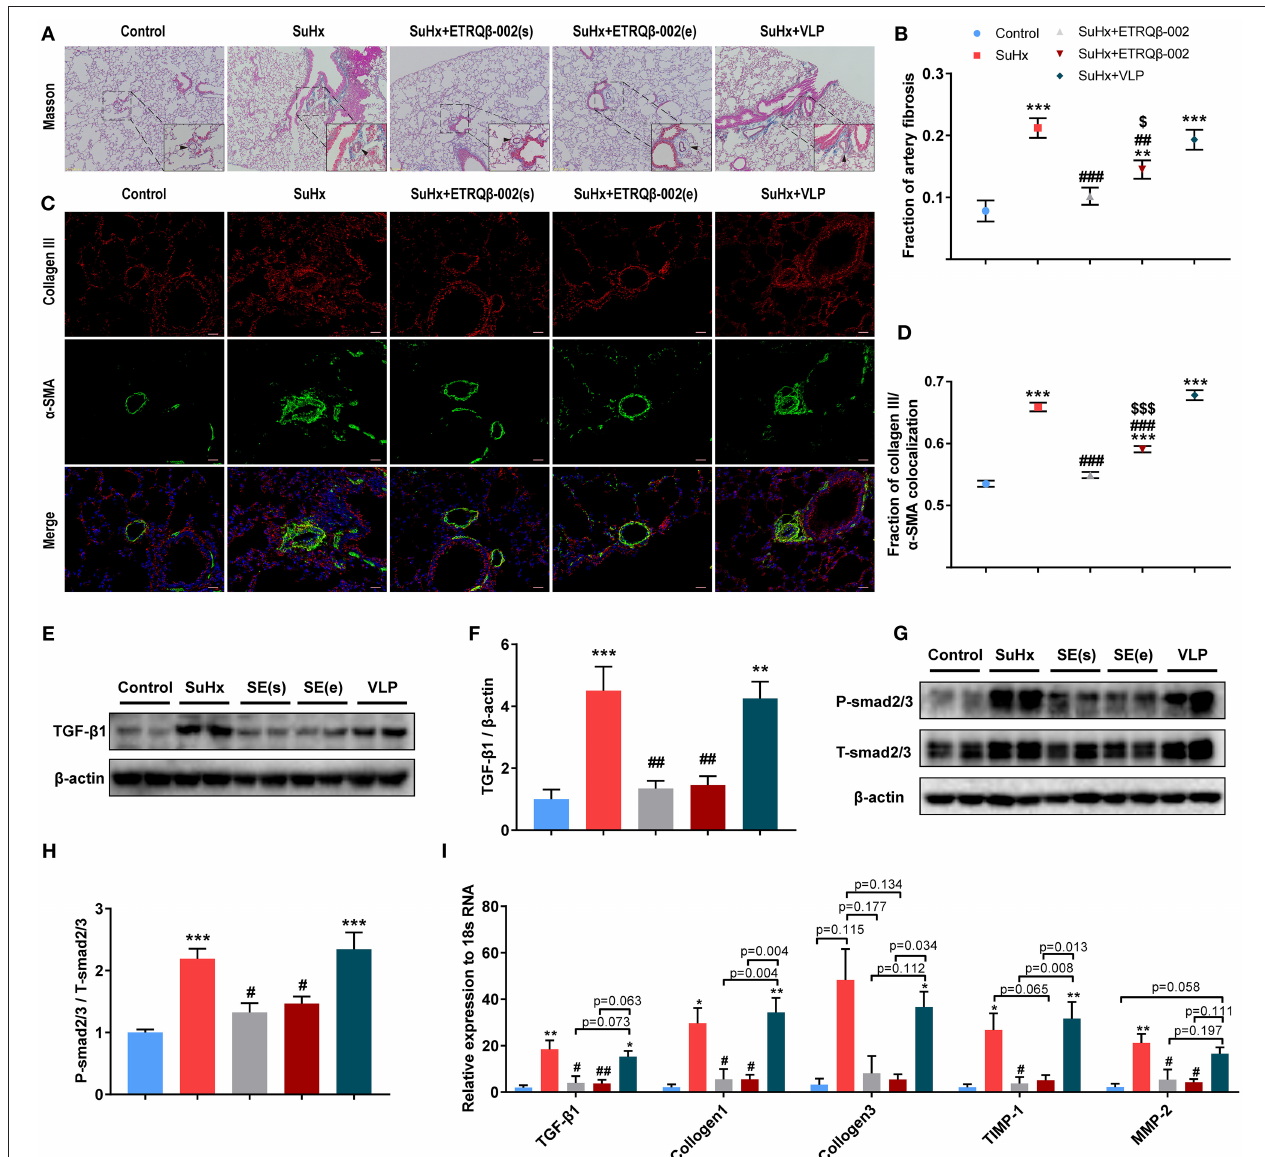
FIGURE 4 | ETRQ β -002 vaccine effectively reduced fibrosis of PA in SuHx-induced PAH mice. (A) Representative photographs of Masson trichrome staining of lung sections from each group (scale bar = 50 µ m). (B) Percentage of PA fibrosis burden ( n = 6-8). (C) Representative photographs of collagen III/ α -SMA double-immunofluorescence staining of lung sections from each group (scale bar = 20 µ m). (D) The fraction of α -SMA–collagen III colocalization ( n = 5). (E,F) Representative immunoblot, corresponding densitometric analysis of TGF- β 1 ( n = 6). (G,H) Representative immunoblot, corresponding densitometric analysis of psmad2/3 and total smad2/3 (n = 6). (I) Quantitative RT-PCR (qRT-PCR) analysis of fibrosis-related factors in lung homogenate from five groups ( n = 4–5). The black arrows refer to the PAs. All data are expressed as the mean ± SEM. * P < 0.05, ** P < 0.01, *** P < 0.001 vs. the control group. # P < 0.05, ## P < 0.01, ### P < 0.001 vs. the SuHx group. $ P < 0.05, $$$ P < 0.001 vs. the SuHx + ETRQ β -002(s)